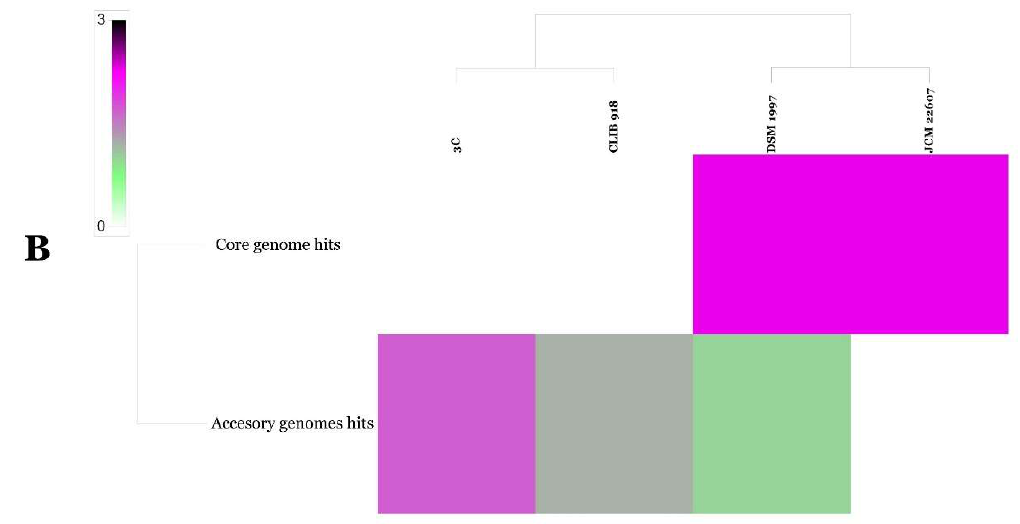
Figure 3. Heat map of the mining of genes contributing to secondary metabolite clusters ( A ). antiSMASH hits of core and accessory genomes ( B ) of examined Geotrichum and Penicillium strains.